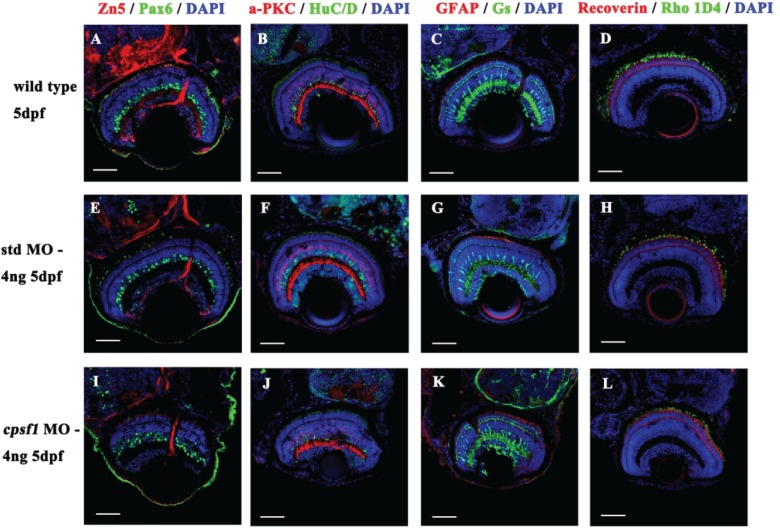
Retinal cells developed normally in WT larvae (A-D), std MO larvae (E-H) and cpsf1 morphants (I–L). (A, E, I) Co-labelling with anti-Pax6 (for ganglion and amacrine precursor cells, green) and anti-Zn5 (for mature RGCs and their axons, red) antibodies showed that the RGCs were mature. (B, F, J) Co-labelling with anti-HuC/D (for ganglion cells and amacrine cells, green) and anti-α PKC (for bipolar cells, red) antibodies indicated that the amacrine cells and bipolar cells developed normally. (C, G, K) Co-labelling with anti-GS (for Müller cells, green) and anti-GFAP (for glial cells and their axons, red) antibodies demonstrated that the Müller cells and glial cells had attained maturity. (D, H, L) Co-labelling with anti-Rho 1D4 (for long double-cone outer segments, green) and anti-Recoverin (for cone bipolar cells, red) antibodies demonstrated that the photoreceptors grew normally.